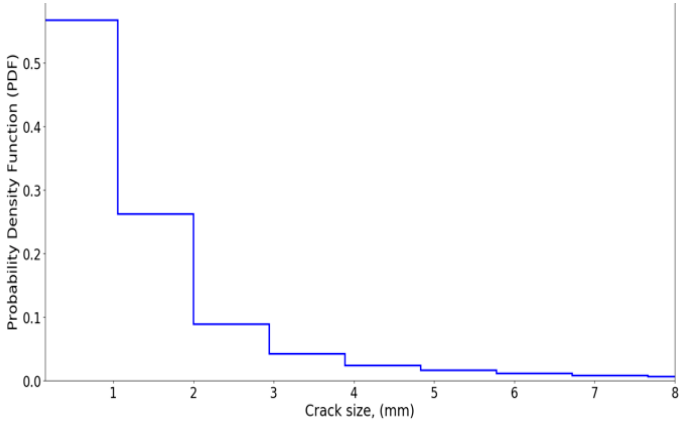
Figure 1. Obtained prior crack size distribution by using the sampling method